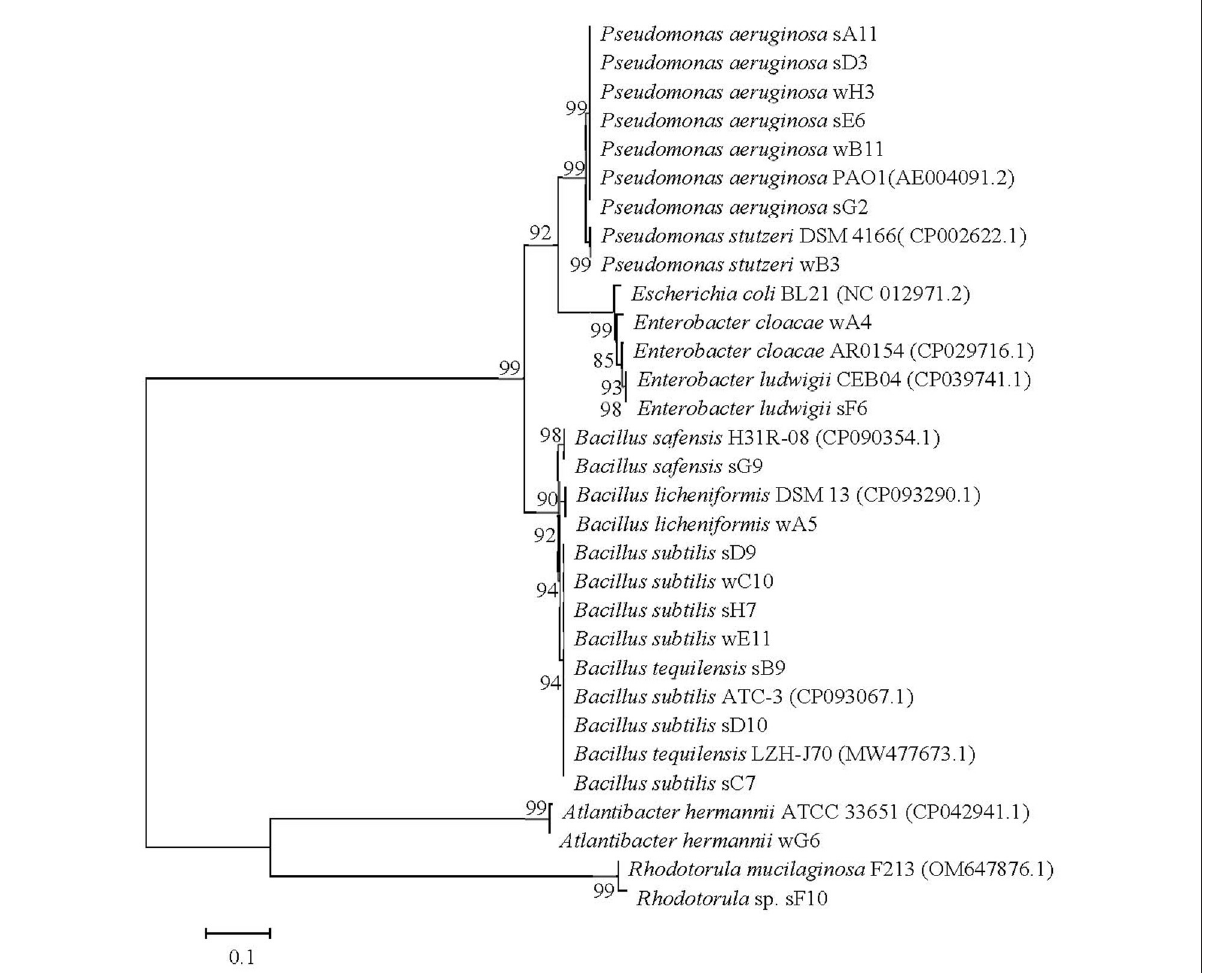
FIGURE2 The phylogenetic tree of the screened microbial strains which can anaerobically biosynthesize biosurfactants, constructed by software Mega 5.0 based on a Neighbor-Joining Algorithm of 1000 resampled datasets. Bar, 0.1 nucleotide substitutions per site.